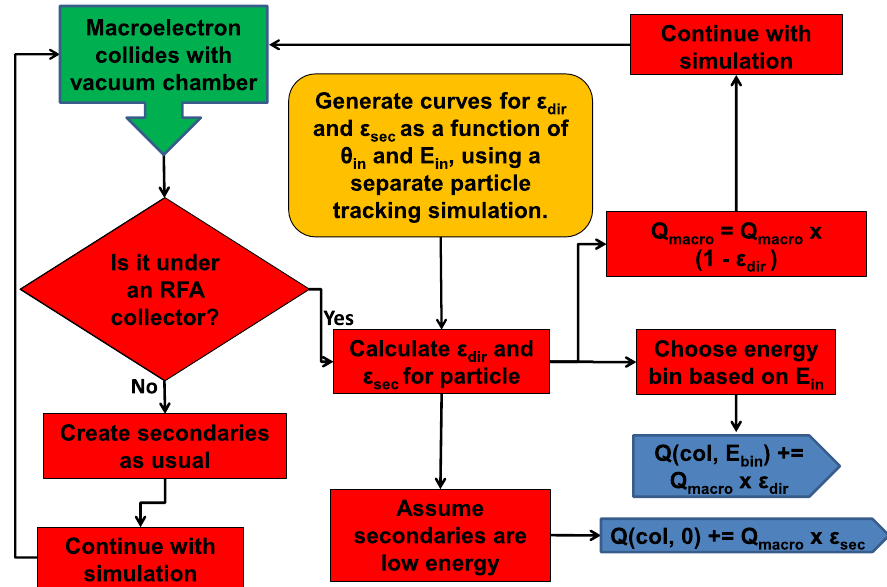
FIG. 4. Conceptual flowchart of the RFA model in POSINST . The charge deposited in the collector is binned by energy and collector Þ ]. The magnitude of this quantity depends on the macroelectron charge ( Q number [ Q ð col ; E bin which in turn depends on the incident particle energy ( E “ secondary ” charge [ Q ð col ; 0 Þ ], depending on the secondary efficiency ( ε are considered lost. Charge that enters the RFA is removed from the